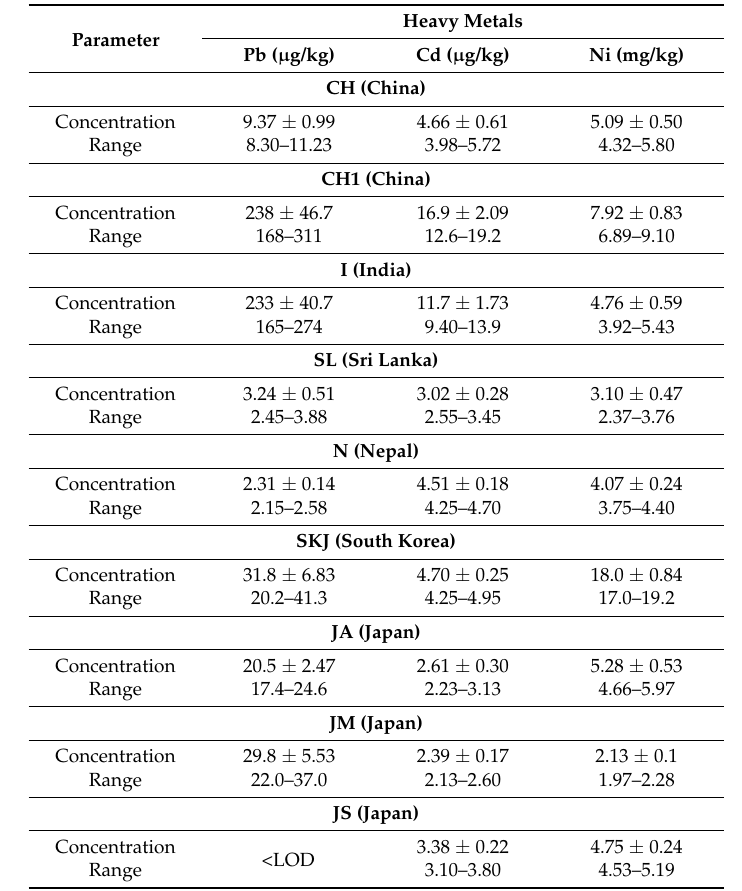
Table 4. The average content of toxic heavy metals in green tea samples according to their origin (including tea type or